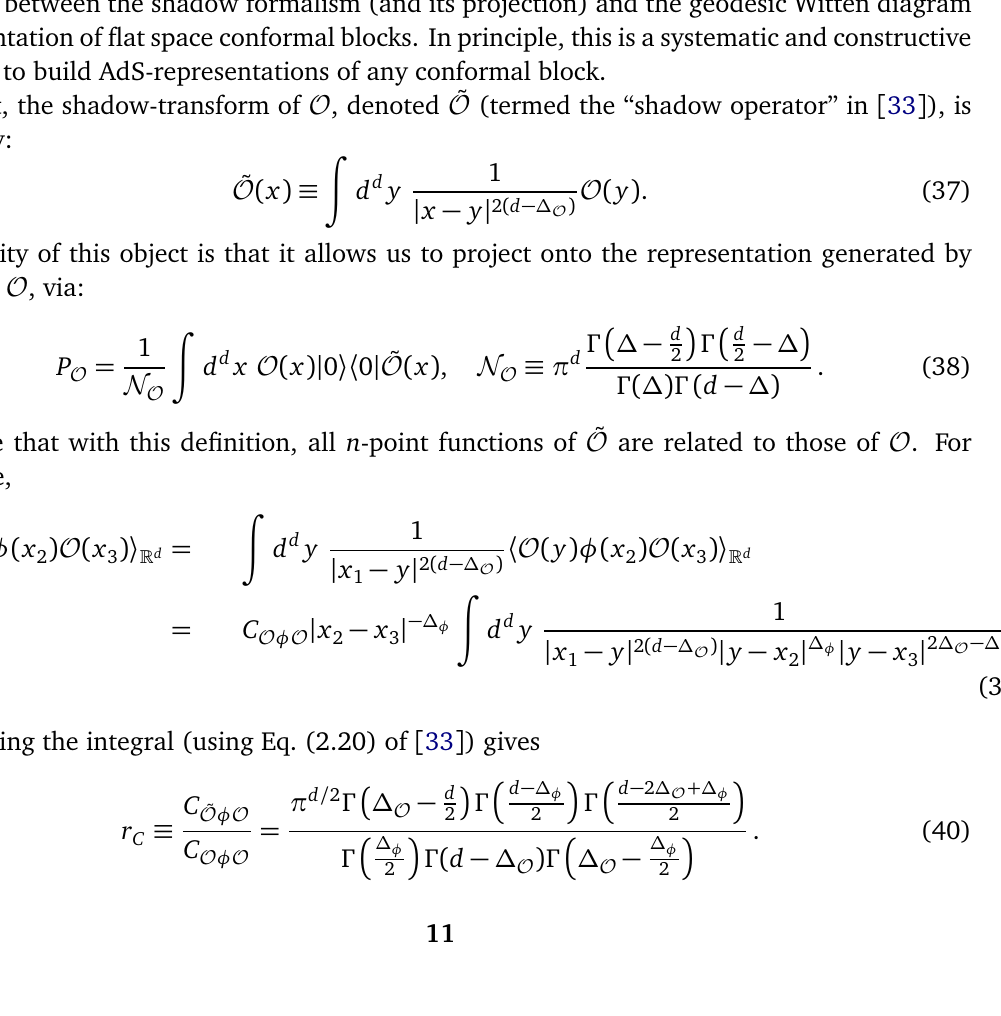
Figure 2: Bulk dual of the thermal one-point block bulk-to-boundary propagator for ∆ φ , and the red line represents the propagator for the particle to propagate once around the thermal O